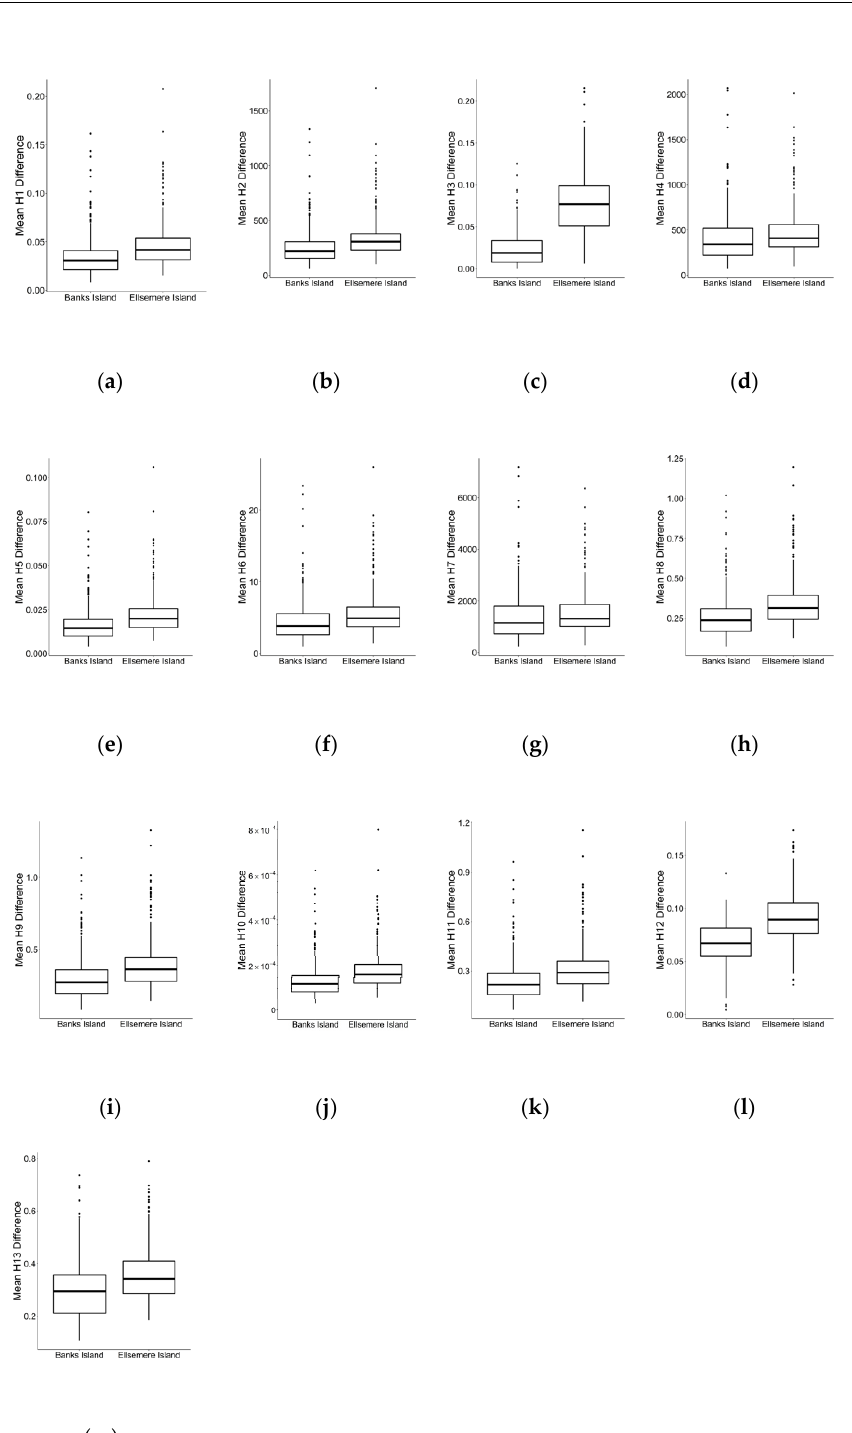
Table 7. Statistical comparison of Haralik texture features of hand-annotated RTS samples from Eureka Sound Lowlands and Banks Island using independent Wilcoxson test. (n = 475).